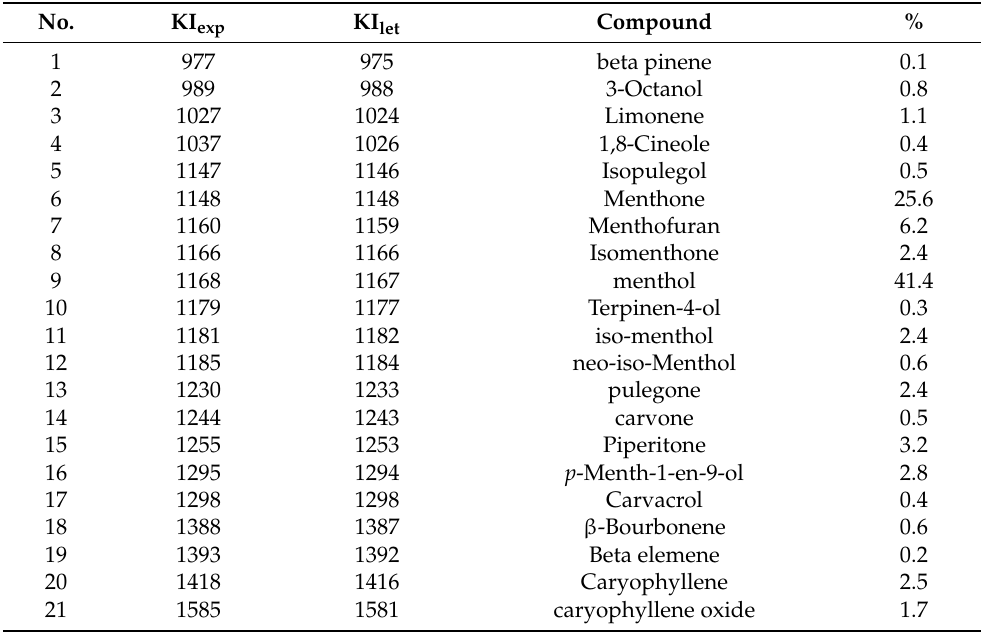
Table 3. Main chemical composition of Mentha piperita L. essential oil using GC/MS. KI exp : experi- mental kovats index; KI let : literature kovats